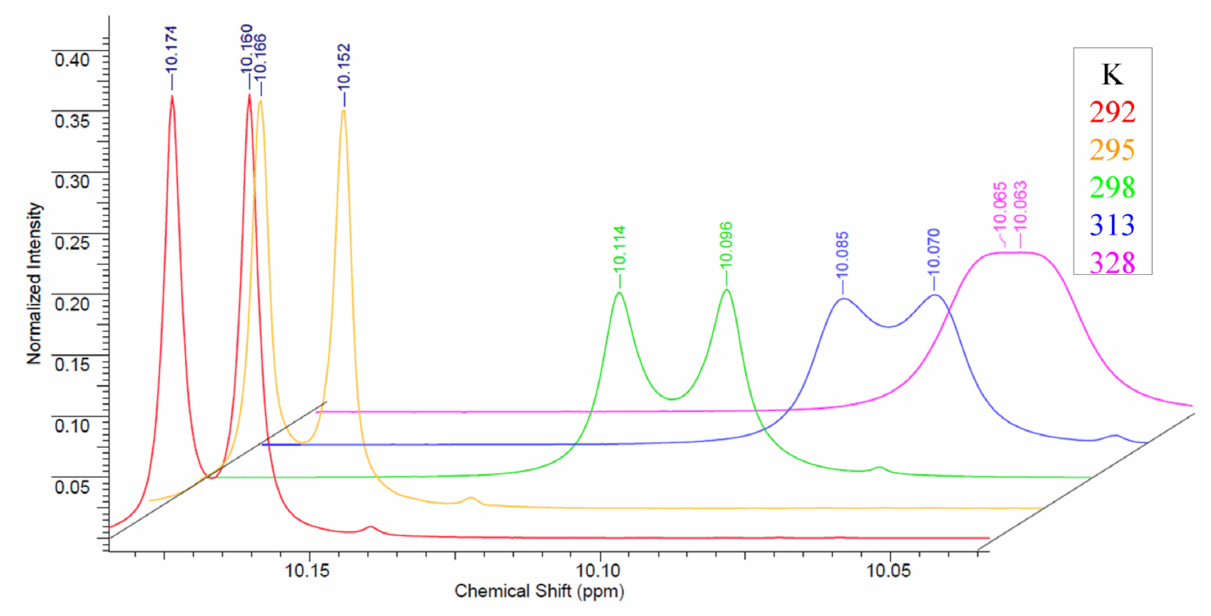
Figure 2. 1 H NMR spectra of compound 9 recorded in acetone-D 6 at different